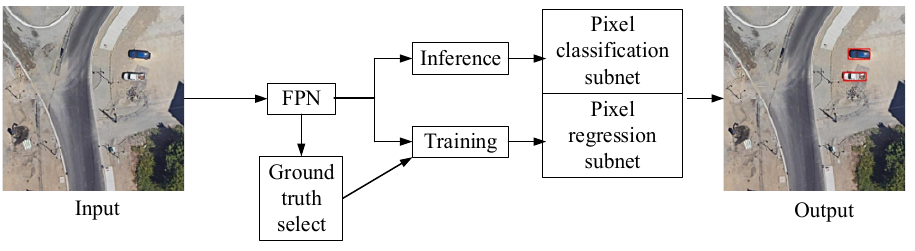
Figure 2. RetinaNet network structure.